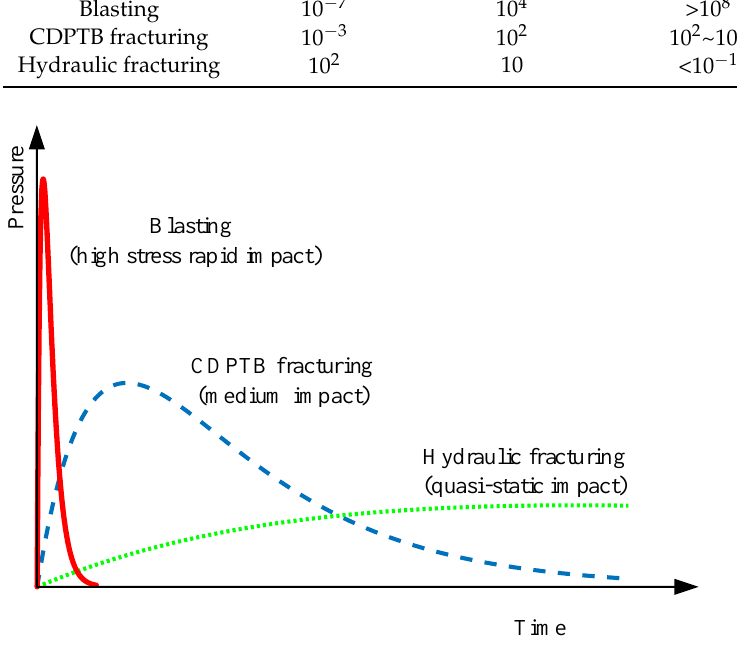
Figure 6. Pressure time history curve of different fracturing methods.